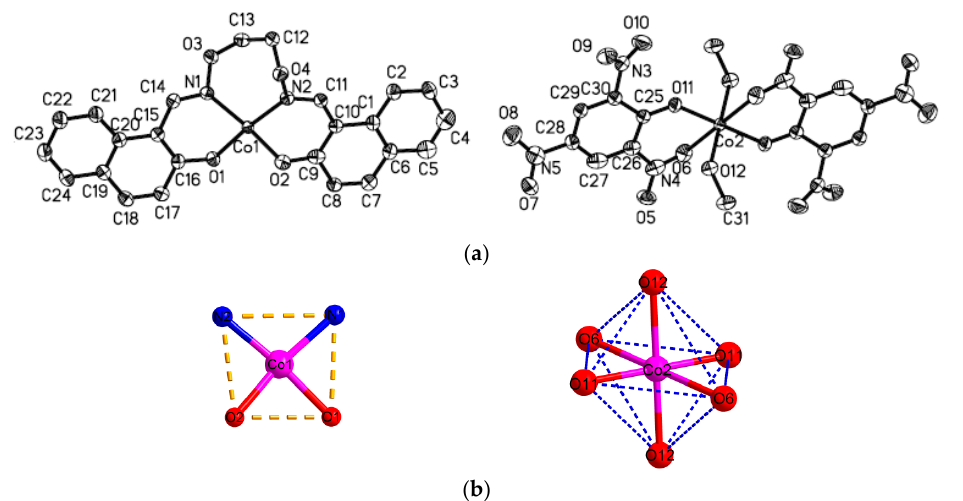
Figure 3. ( a ) View of the coordination environment of Co(II) center with thermal ellipsoids at 30% probability in 1 with a labelling scheme (all H atoms have been omitted for clarity); ( b ) The coordination polyhedron of Co(II) in 1 .